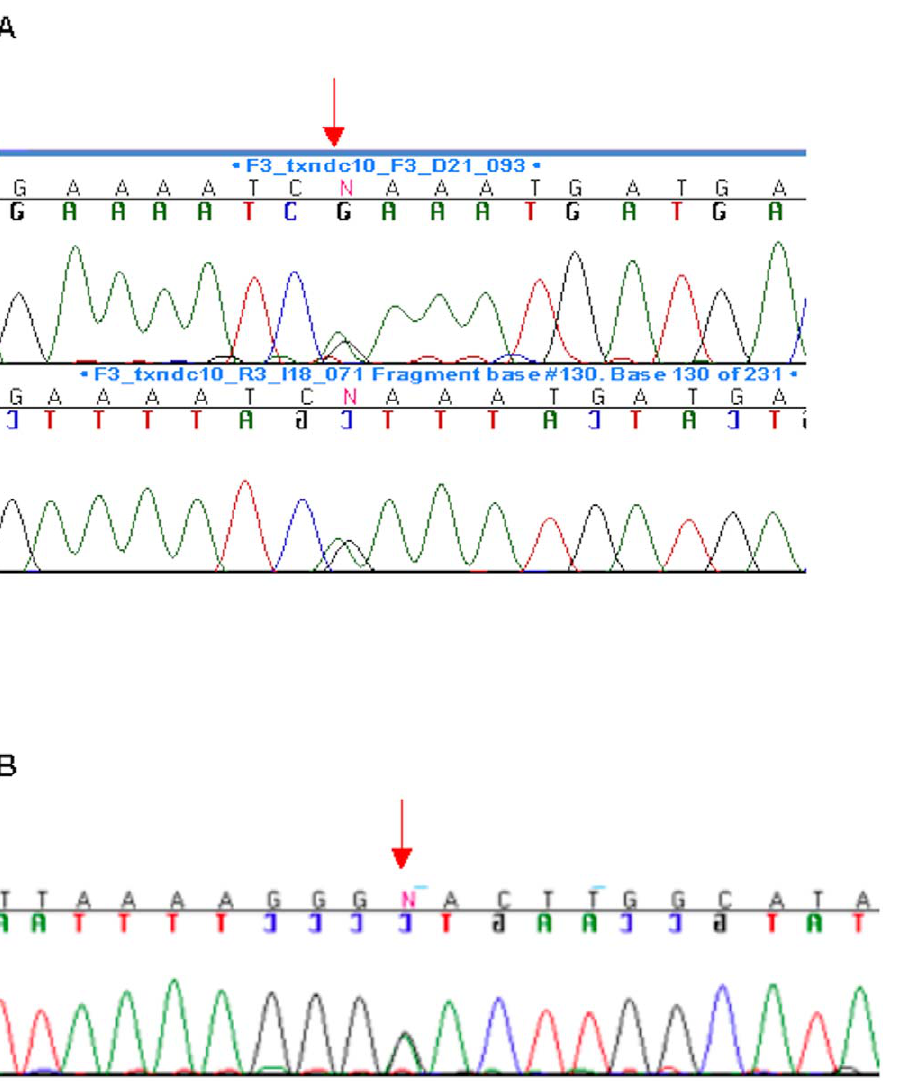
Figure 3. Two patients unrelated to our propositus with microphthalmia have sequence alterations predicting amino acid substitutions in TMX3 . Fig. 3A. Chromatogram showing c.116G . A, predicting p.Arg39Gln in TMX3 . Arrow points to the site of the sequence alteration. Fig. 3B. Chromatogram showing c.322G . A, predicting p.Asp108Asn in TMX3 . Arrow points to the site of the sequence alteration.